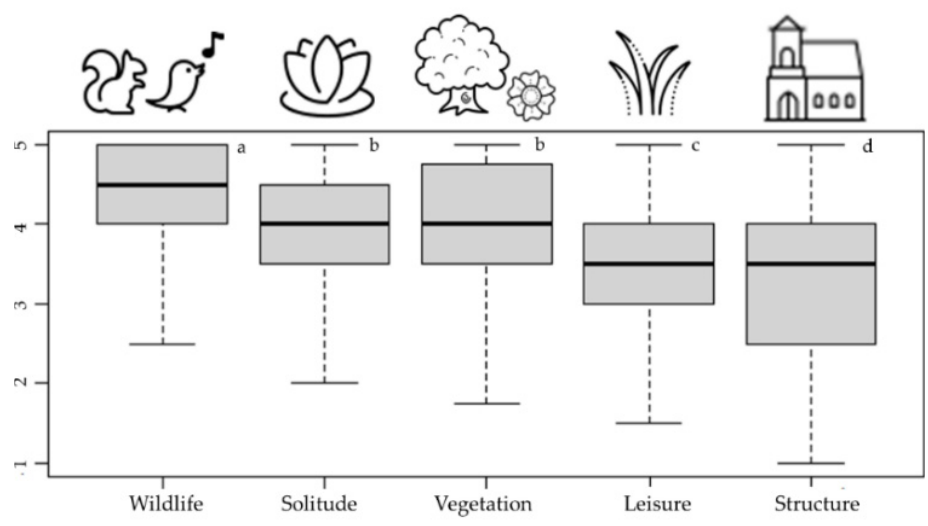
Figure 4. Preferences for five overarching cemetery characteristics (wildlife, solitude, vegetation, leisure, and structure) that were rated by participants ( n = 627). Scale of 1 (‘not at all’) to 5 (‘very much’). Significant differences indicated with different letters at the level p < 0.001.